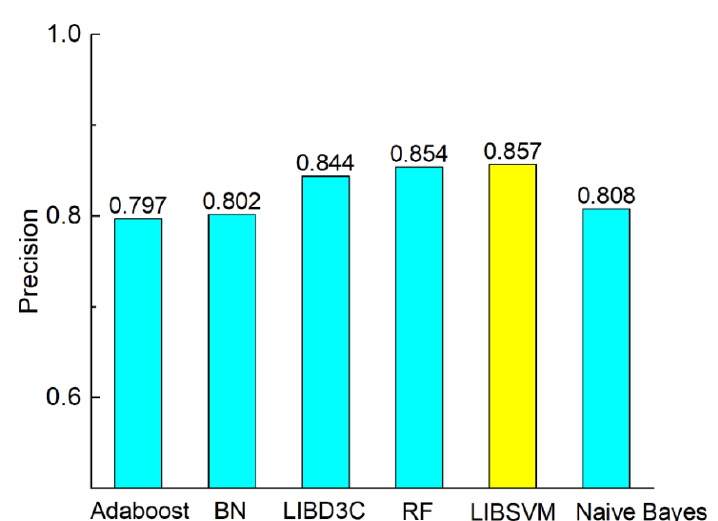
Figure 3. Comparison of ACC on different classifiers. Molecules 2018 , 23 , x FOR PEER REVIEW